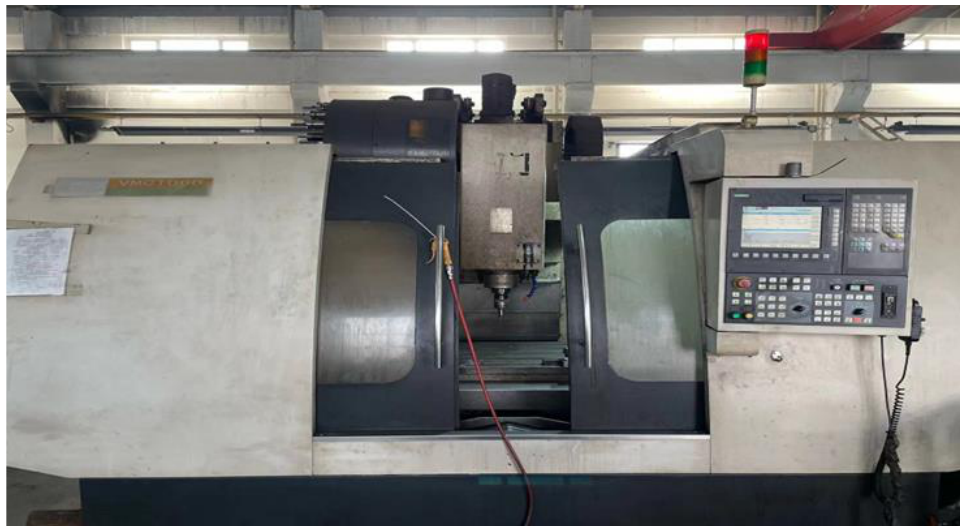
Figure 5. Experimental subject: VMC1060 vertical machining center.